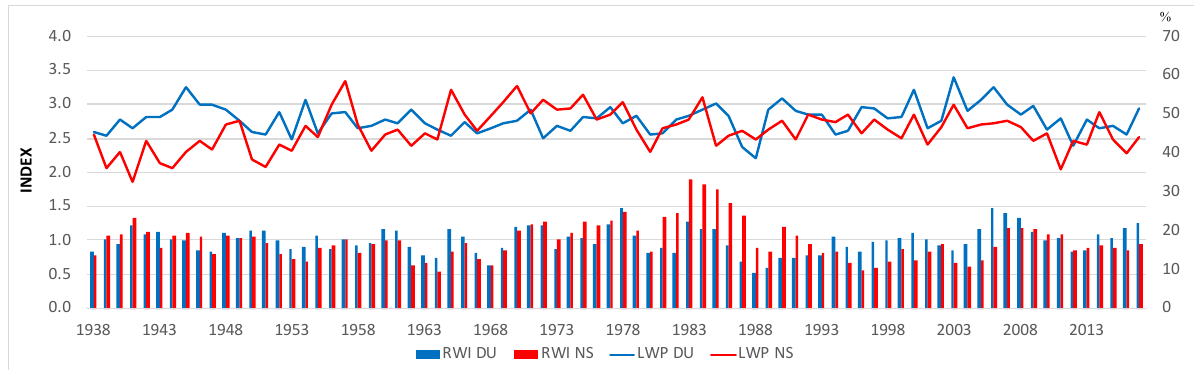
Figure 2. Variation of the ring width index (RWI) and latewood percentage (LWI) of Douglas fir (DU) and Norway spruce (NS) in FGR 1.